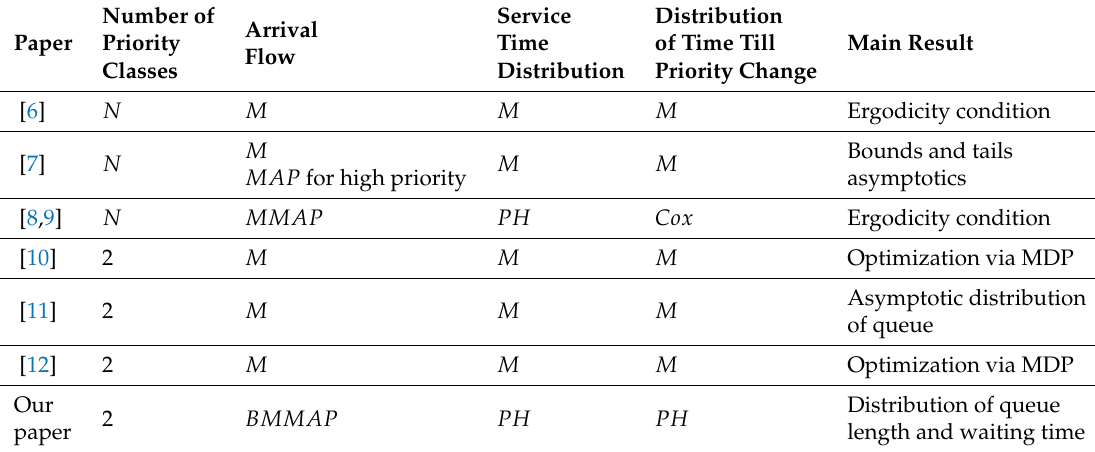
Table 1. Results for queues with changing